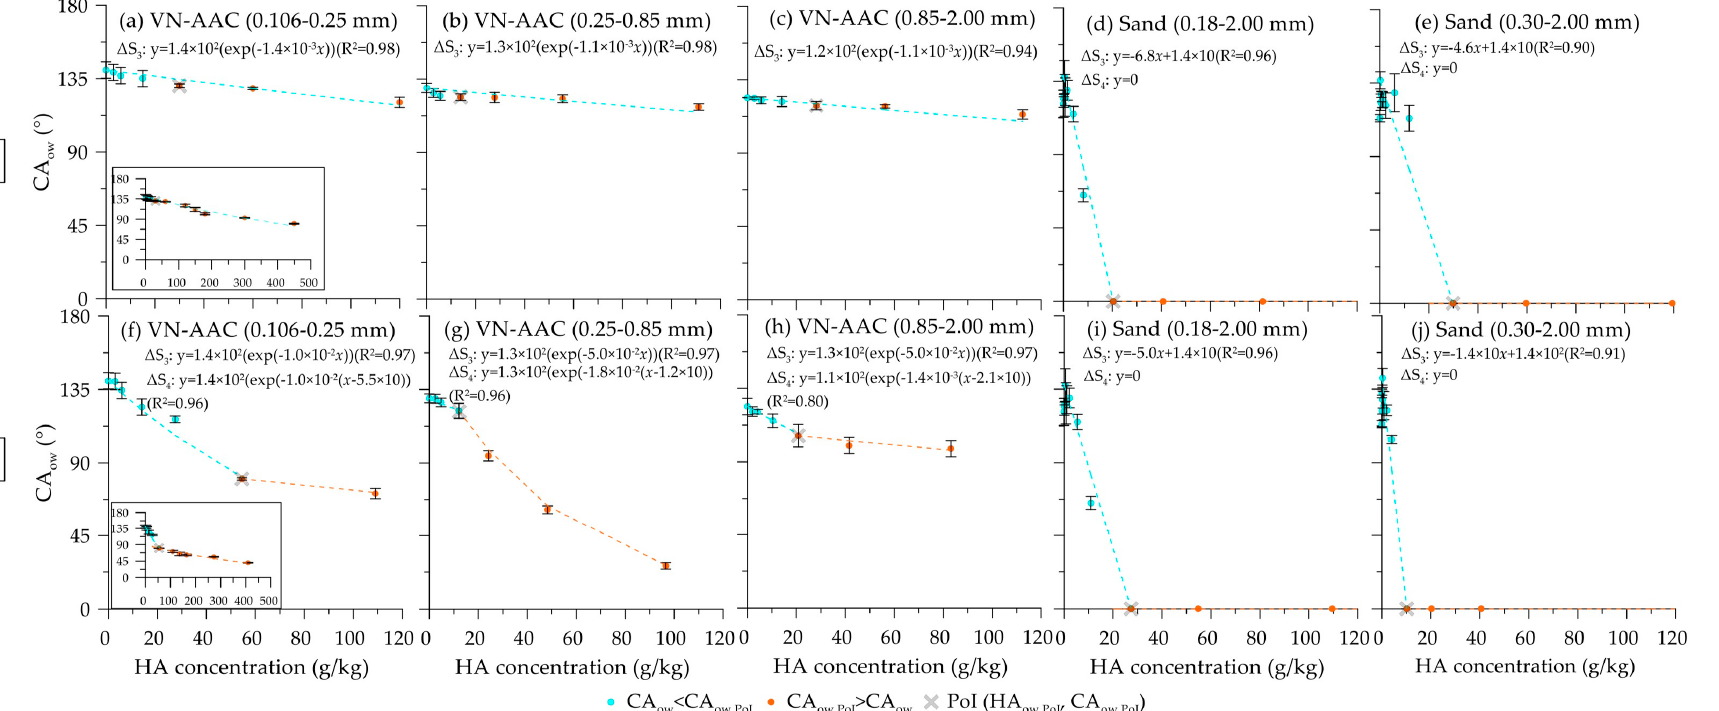
Figure 5. Relationships between CA ow and HA concentration of OA- and SA-coated VN-AAC grains and sands. OA-coated VN-AAC grains: ( a ) Grain size = 0.106–0.25 mm, ( b ) Grain size = 0.25–0.85 mm, and ( c ) Grain size = 0.85–2.00 mm. OA-coated sands: ( d ) Grain size = 0.18–2.00 mm and ( e ) Grain size = 0.30–2.00 mm. SA-coated VN-AAC grains: ( f ) Grain size = 0.106–0.25 mm, ( g ) Grain size = 0.25–0.85 mm, and ( h ) Grain size = 0.85–2.00 mm. SA-coated sands: ( i ) Grain size = 0.18–2.00 mm, and ( j ) Grain size = 0.30–2.00